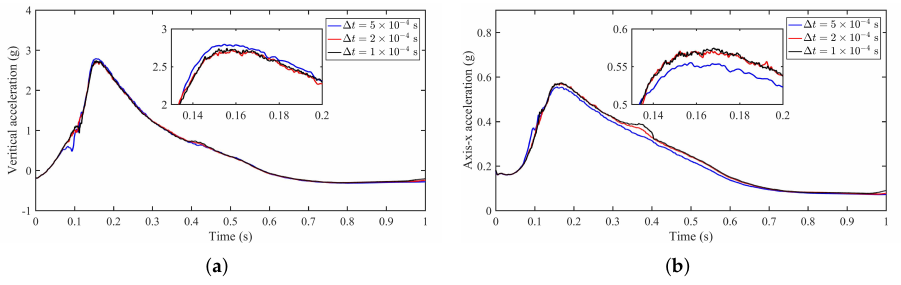
Figure 6. Results of time step dependency study: ( a ) vertical acceleration; ( b ) axis-x/horizontal acceleration.